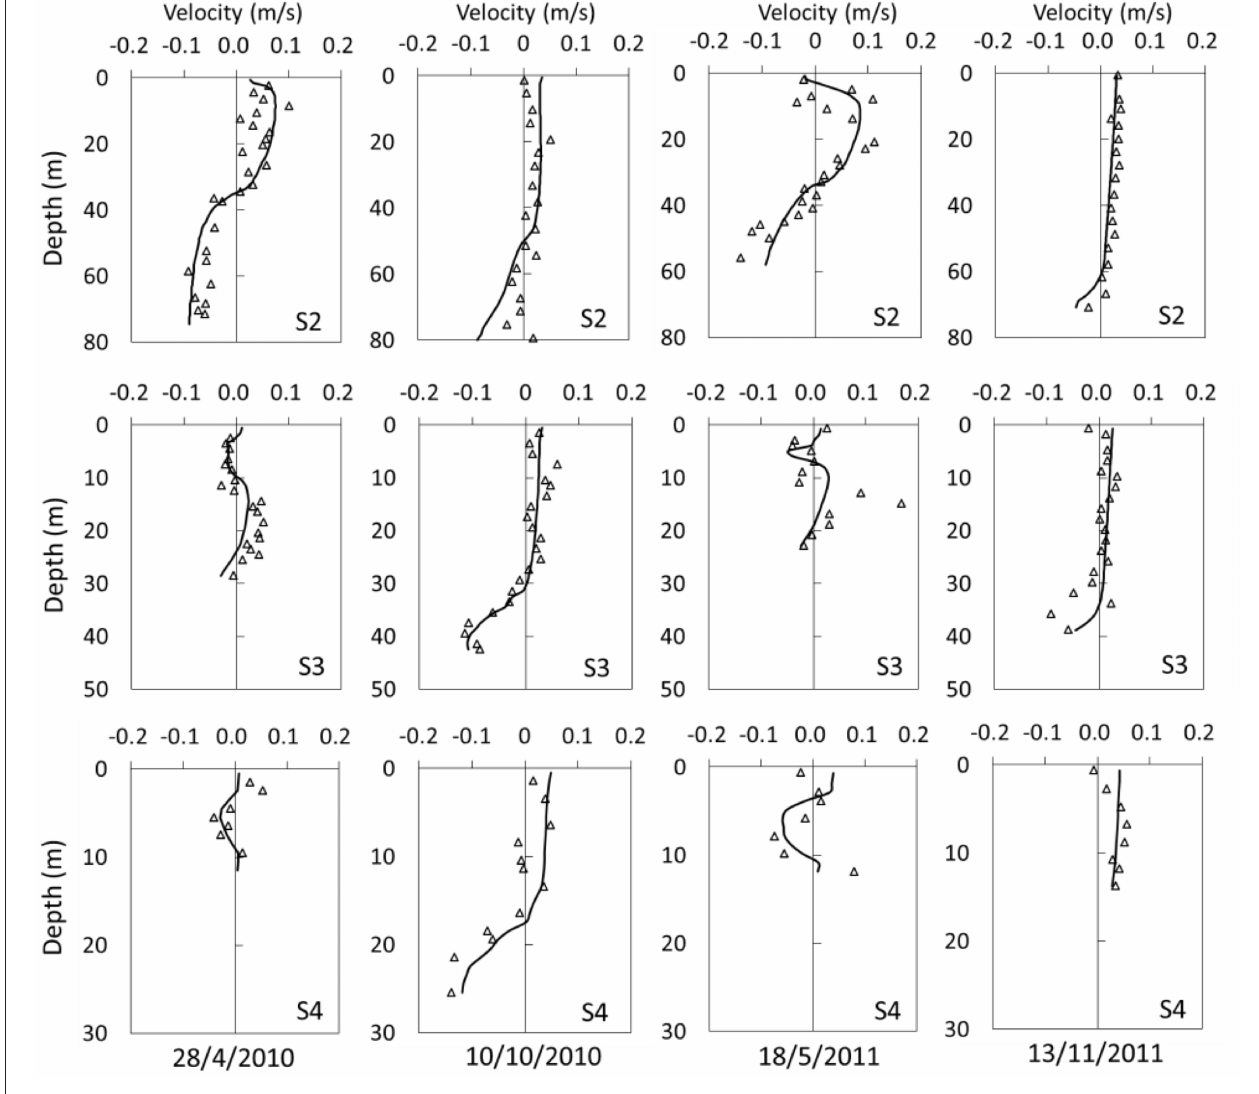
Frontiers in Ecology and Evolution |